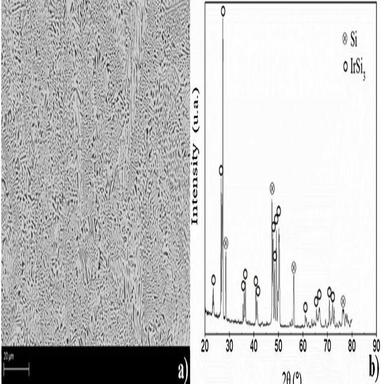
As-produced Si-62 wt%Ir eutectic alloy by arc melting: a) SEM image at the cross-section and b) XRD pattern.